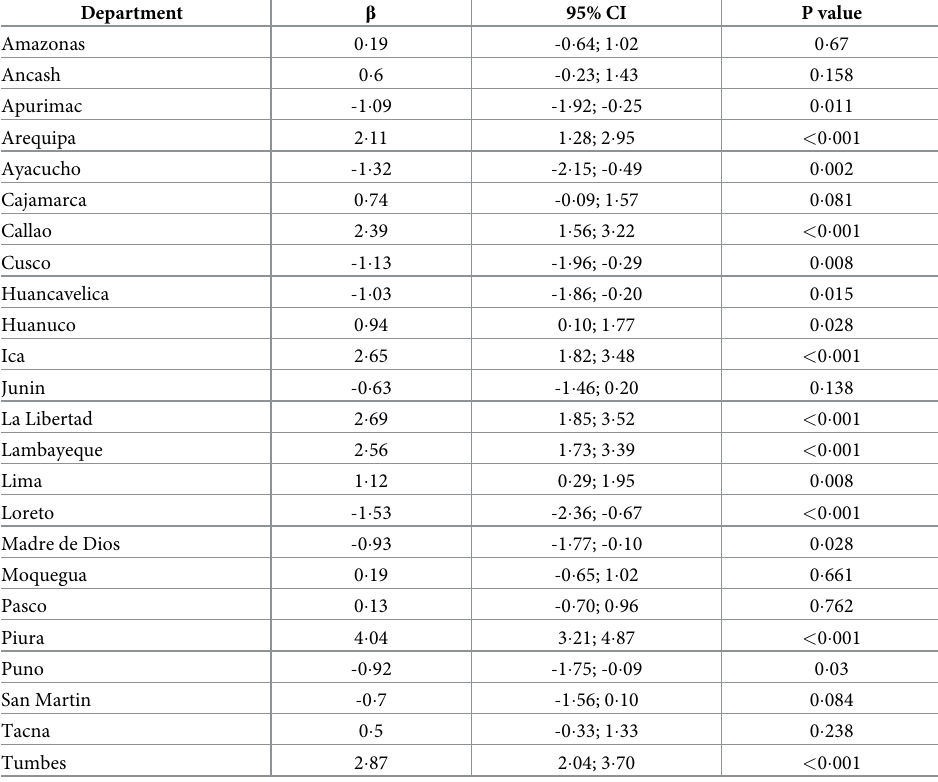
Table 2. Mixed lineal models between department-year and proportion of deaths in departments in Peru (period